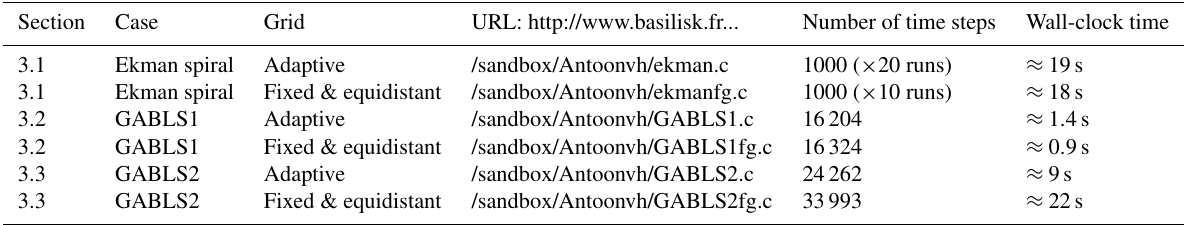
Table 1. The exact formulation of the methods are described at the online locations of the definition files for the different cases presented in this